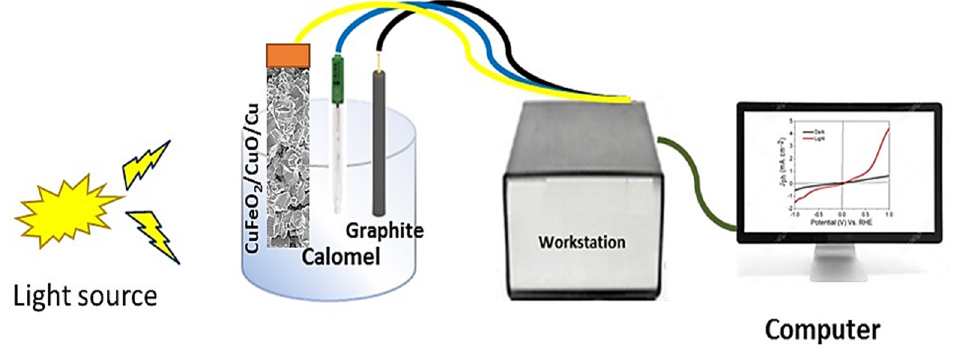
Figure 5. Figure 5. The schematic diagram for the H 2 generation from sewage water, using the CuFeO 2 /CuO/Cu photoelectrode.